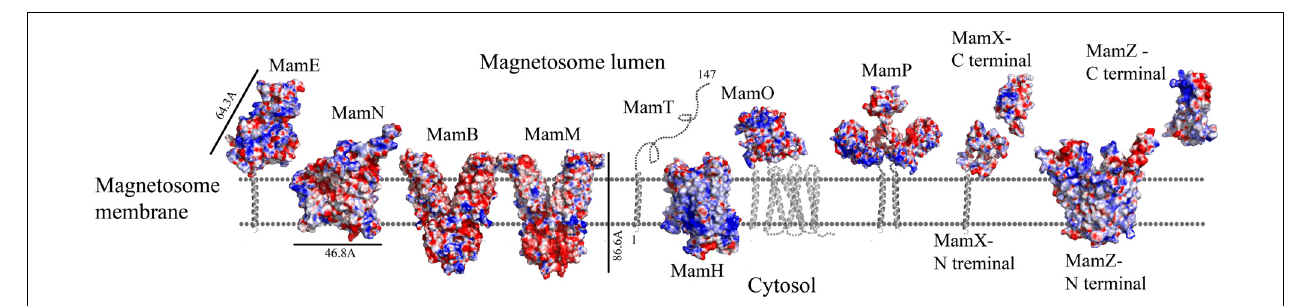
FIGURE 5 | Protein structure predictions that are involved in iron transport and nucleation. Negative charges are in red and positive charges are in blue. Black bars define the protein size in angstroms. Magnetotactic ovoidal bacterium MO-1 MamP structure from was magnetotactic ovoidal bacterium MO-1 is determent by X-ray